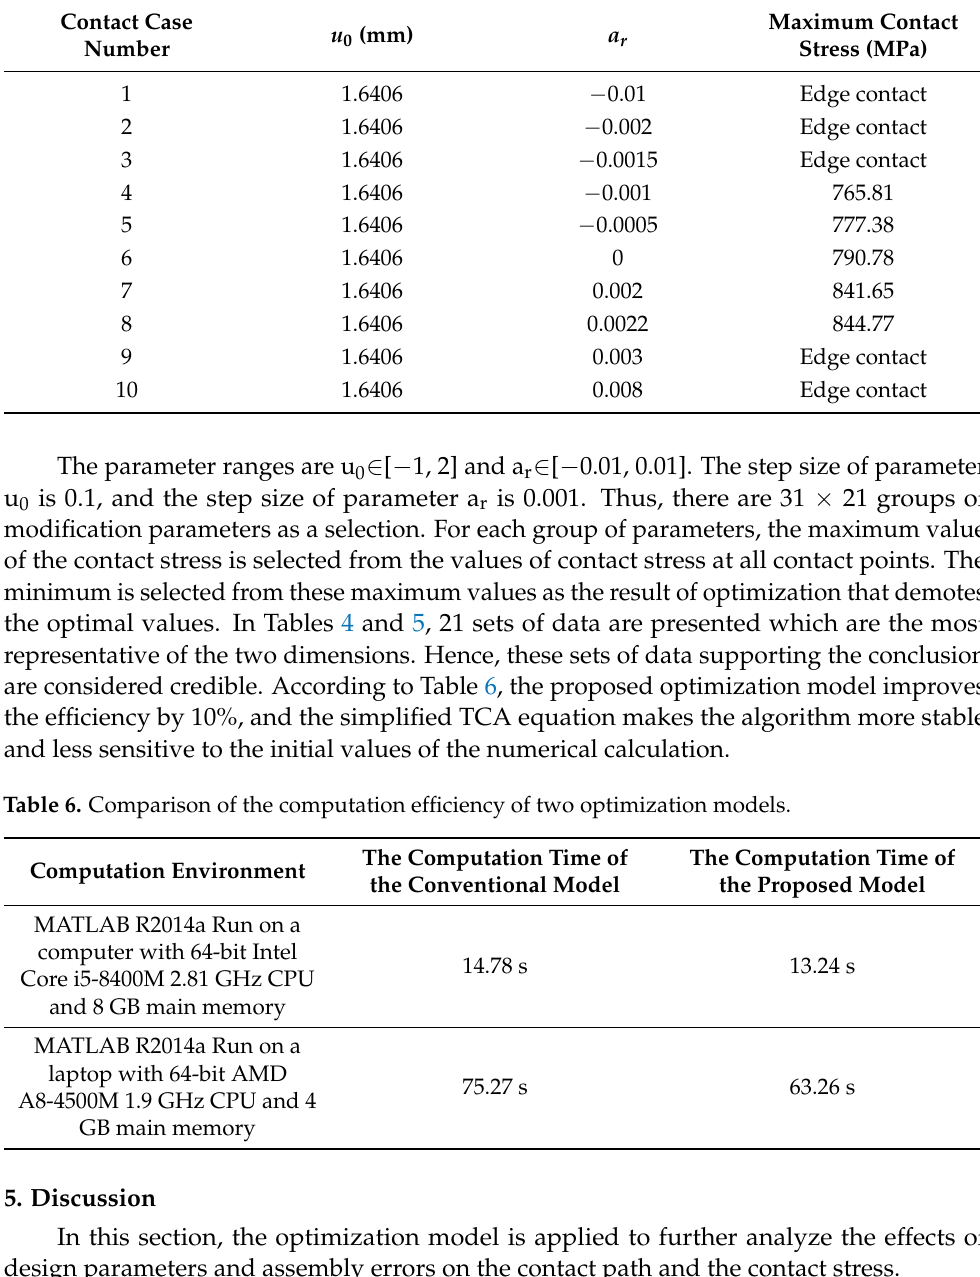
Table 5. Contact stress of different parabolic parameters a r .